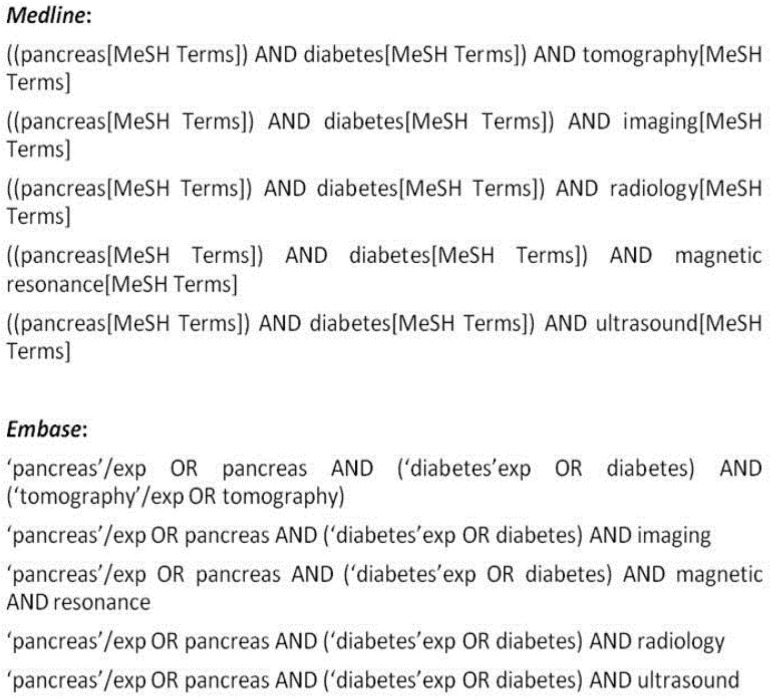
Search strategy used for study selection.